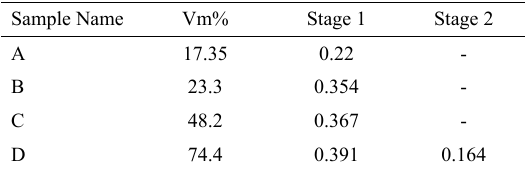
Figure 7. lnσ-lnε curves for investigated steel with different martensite volume fraction. Table 4. Work hardening exponent for different stages for heat- treated